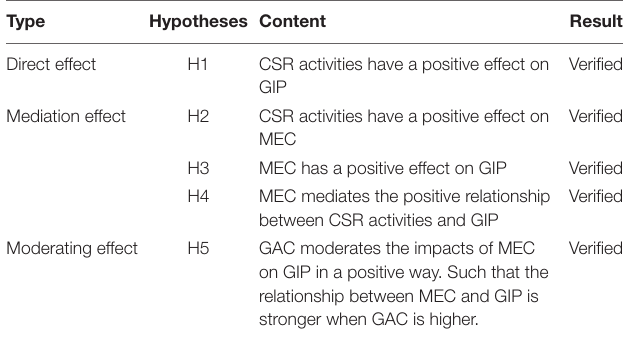
TABLE 8 | Summary of hypotheses.